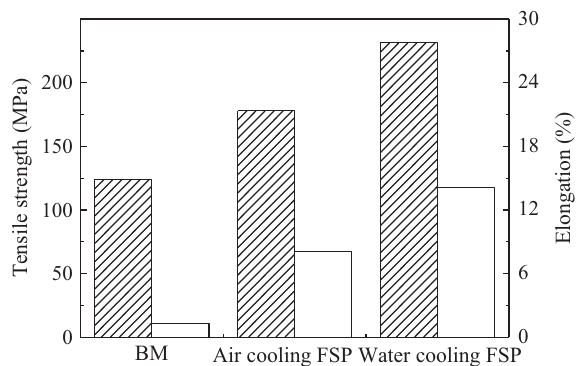
Figure 7: Tensile properties of these specimens.